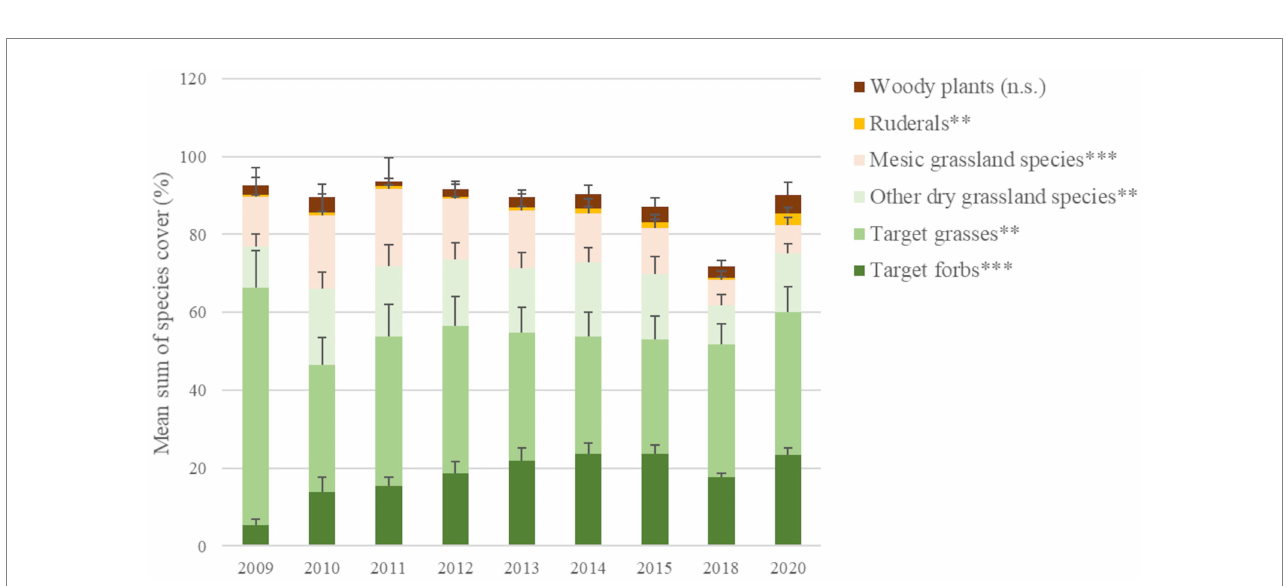
FIGURE 3 Mean cumulative cover of vascular plant species in grazed vegetation surveys (5 m × 5 m, n = 8). Significant changes in ecological groups over 9 observational years (2009 to 2015, 2018, 2020) are marked with asterisks (n.s. not significant, * p < 0.05, ** p < 0.01, *** p < 0.001; Friedman tests: Target forbs: df = 8; Qui-s. = 36.800; p < 0.001; target grasses: df = 8; Qui-s. = 23.933; p = 0.002; other dry grassland species: df = 8; Qui-s. = 25.700; p = 0.001; mesic grassland species: df = 8; Qui-s. = 30.407; p < 0.001; ruderals: df = 8; Qui-s. =21.201; p = 0.007; woody plants: df = 8; Qui-s. = 12.865; p = 0.117). Error bars indicate standard